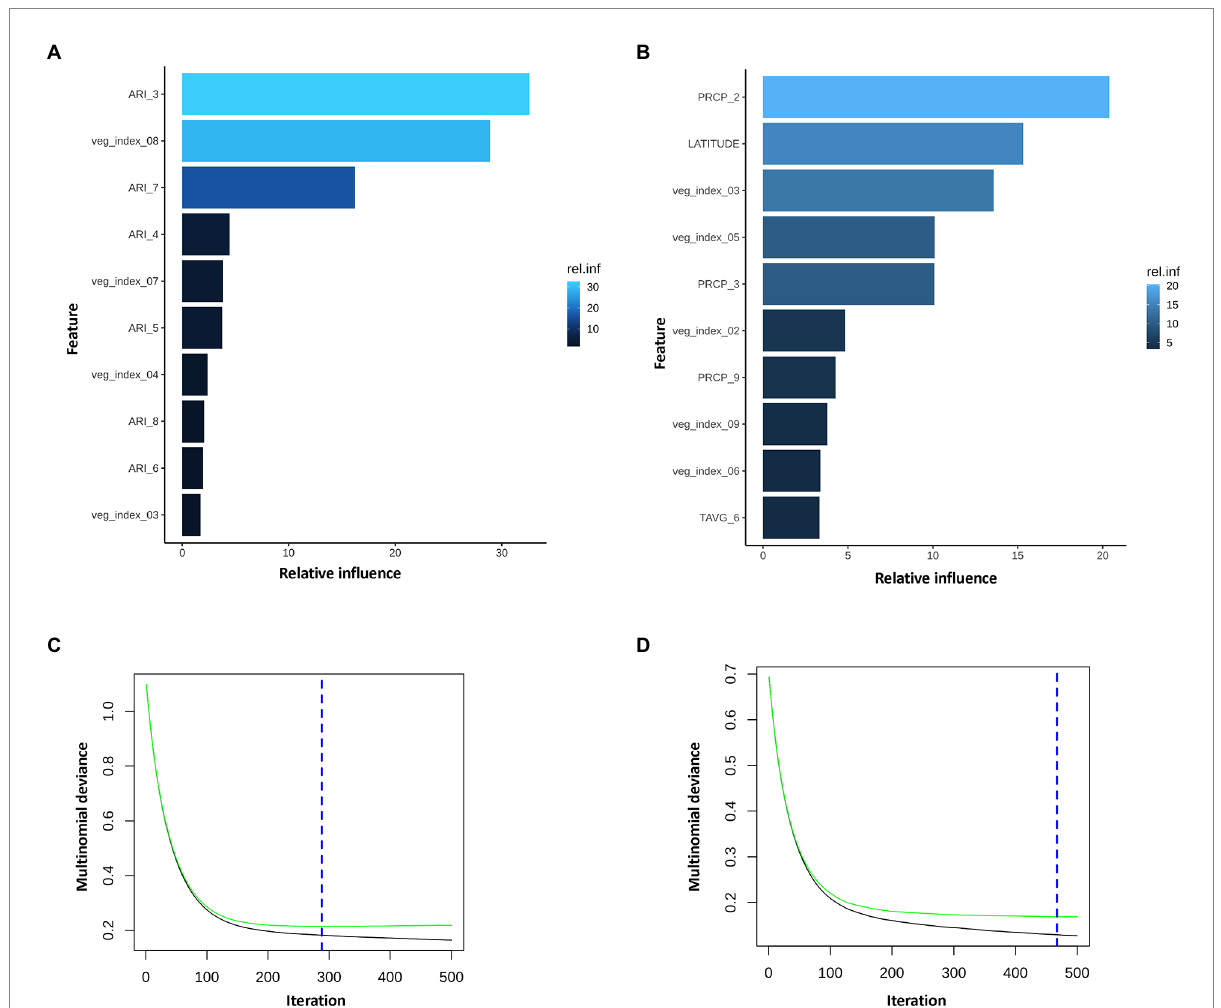
FIGURE 3 Summary of the GBM model using multinomial mycotoxin outcome. Top 10 influential input features and their relative influence over the model in prediction of (A) , AFL and (B) , FUM multinomial variables. Blue hue represents levels of relative influence of the input variables, light blue high and dark blue low influence level (AFL model had 19 of 22 features with non-zero influence; FUM model had 26 of 33 non-zero influence model). Multinomial deviance of (C) , AFL and (D) , FUM. Green line is testing set, black line training set and blue dotted vertical line is the number of iterations used (AFL, 288 iterations; FUM, 467 iterations). AFL model used interaction depth of 1, shrinkage of 0.01 and 3 c.v. folds and fumonisin depth of 1, shrinkage of 0.01 and 10 c.v. folds. FUM model used interaction depth of 1, shrinkage of 0.01 and 10 c.v. folds and fumonisin depth of 1, shrinkage of 0.01 and 10 c.v.